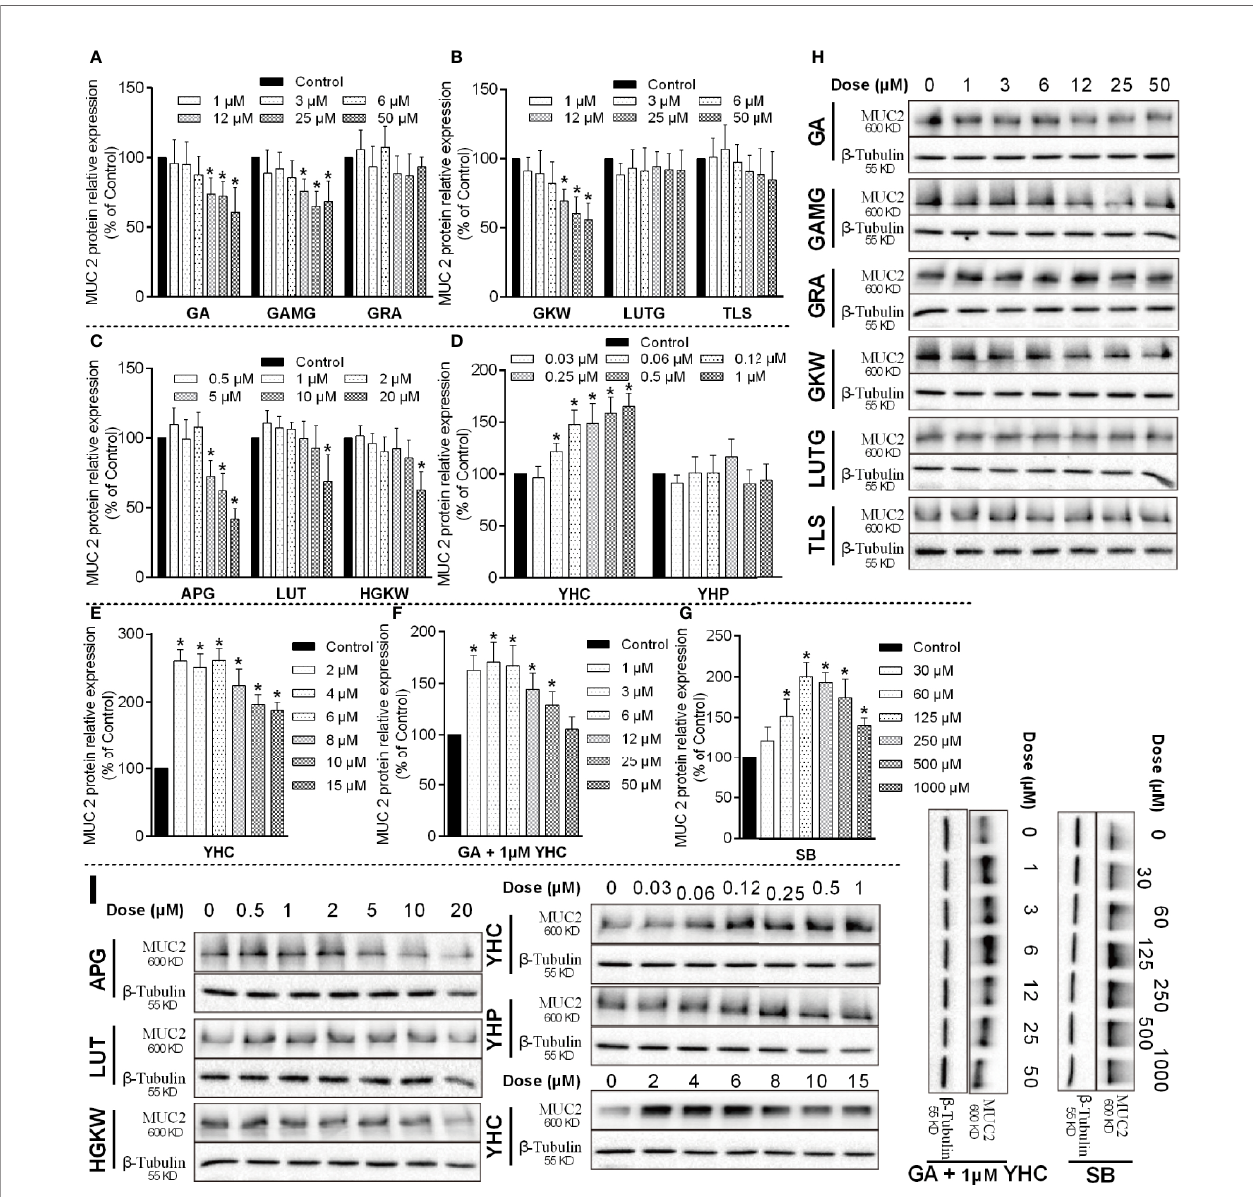
FIGURE 10 | MUC-2 protein expressions in fl uenced by saponins, fl avonoids, and di-terpenes in LS174T cells. (A – G) Bar chart of MUC-2 expressions in LS174T cells treated by the indicated compounds. *P < 0.05 compared with control group. (H, I) Blotting images of MUC-2 expressions in LS174T cells treated by the indicated compounds. LPS is used as positive material, and b -tubulin is used as internal